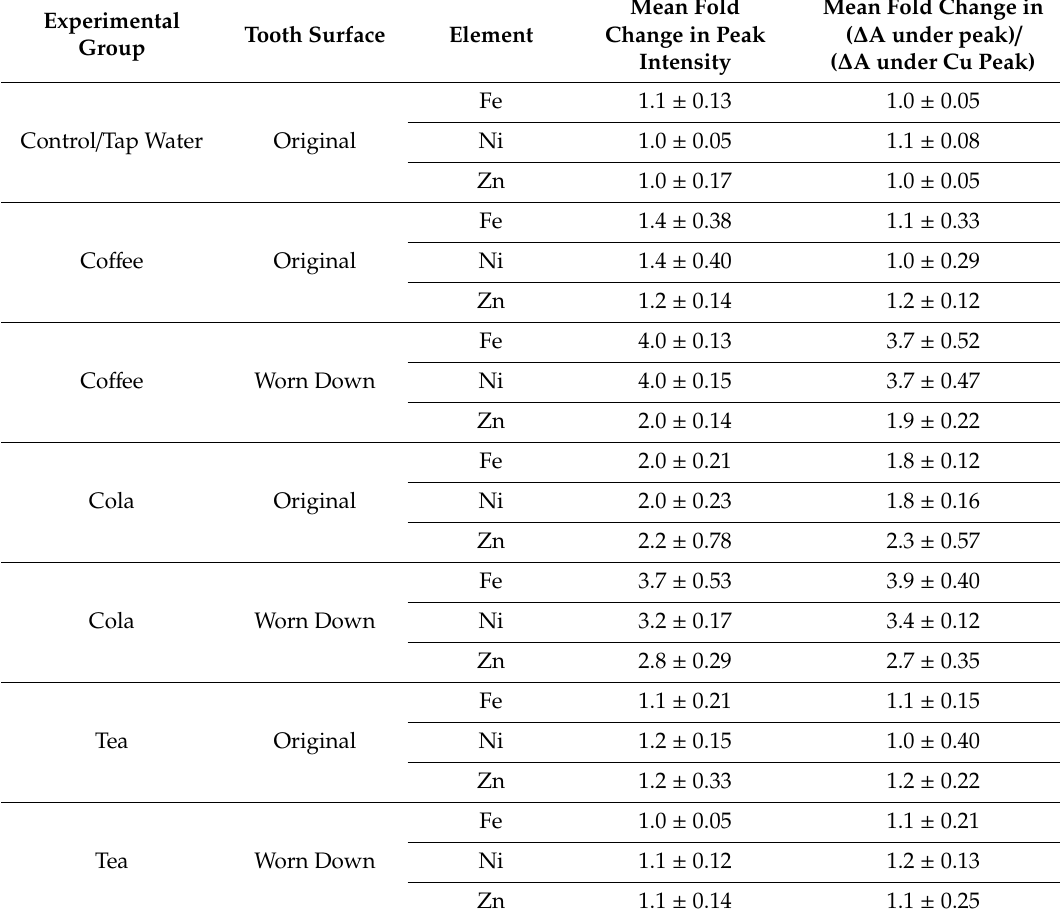
Table 1. Average data collected over multiple trials for each experimental group. Mean fold changes in peak intensity were calculated using the spectrometer software which allows the operator to extract peak values for each element within a spectrum. Mean fold changes which compare the change in area under the peak corresponding to Fe, Ni, or Zn to the change in area under the peak for Cu are also shown. The spectra shown throughout this paper come from one of the trials for each experimental